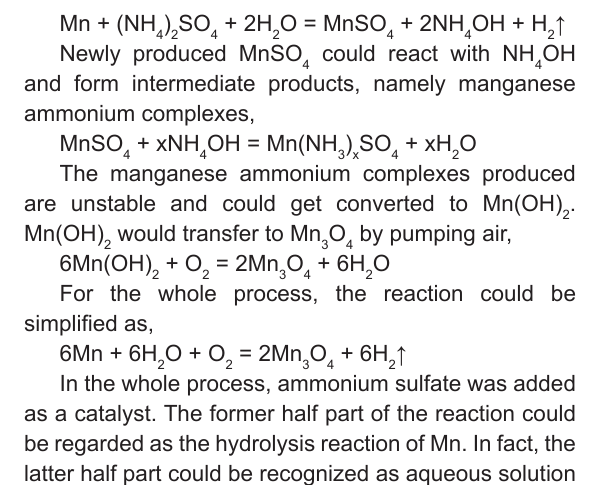
O synthesized 3 4